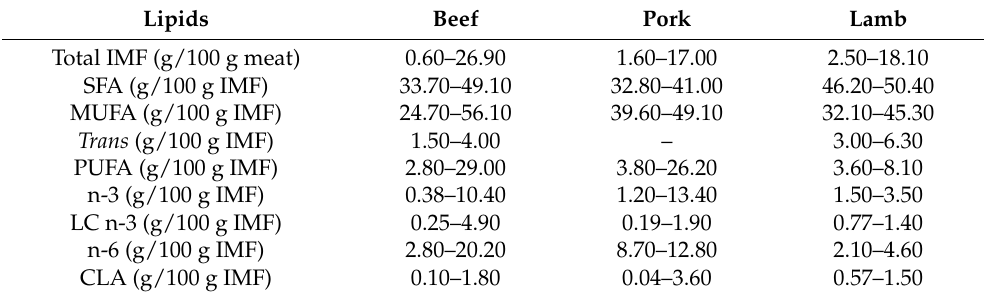
Table 3. Nutrient range of fatty acids in red